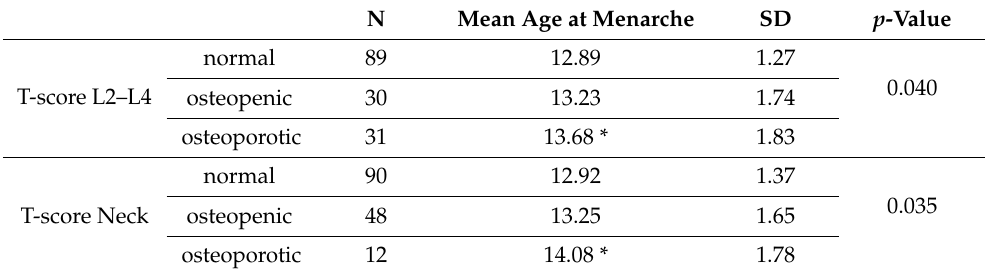
Table 2. Correlation between T-score measurements and age at menarche.